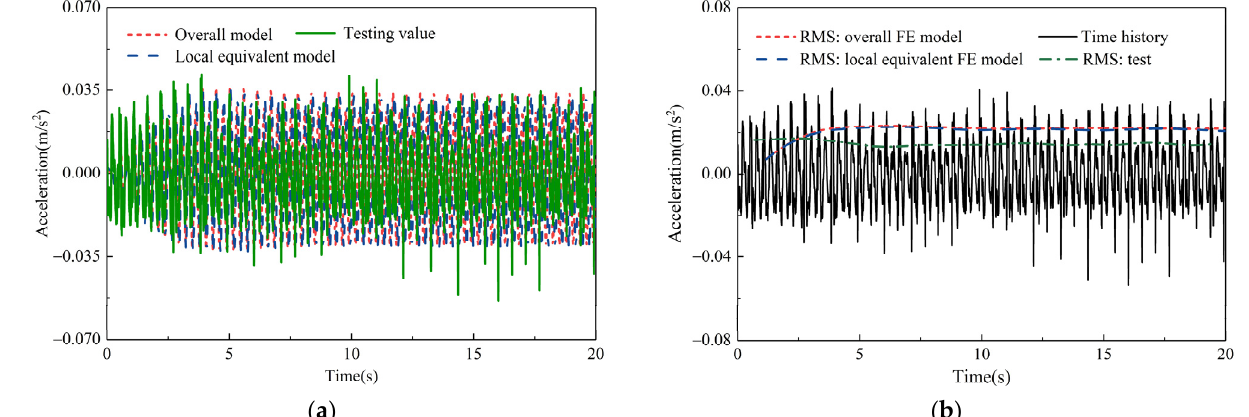
Figure 12. Comparison of numerical and measured acceleration time-history responses and 20 s RMS acceleration of the suspended floor under case WP-2: ( a ) acceleration time-history responses; ( b ) RMS acceleration.